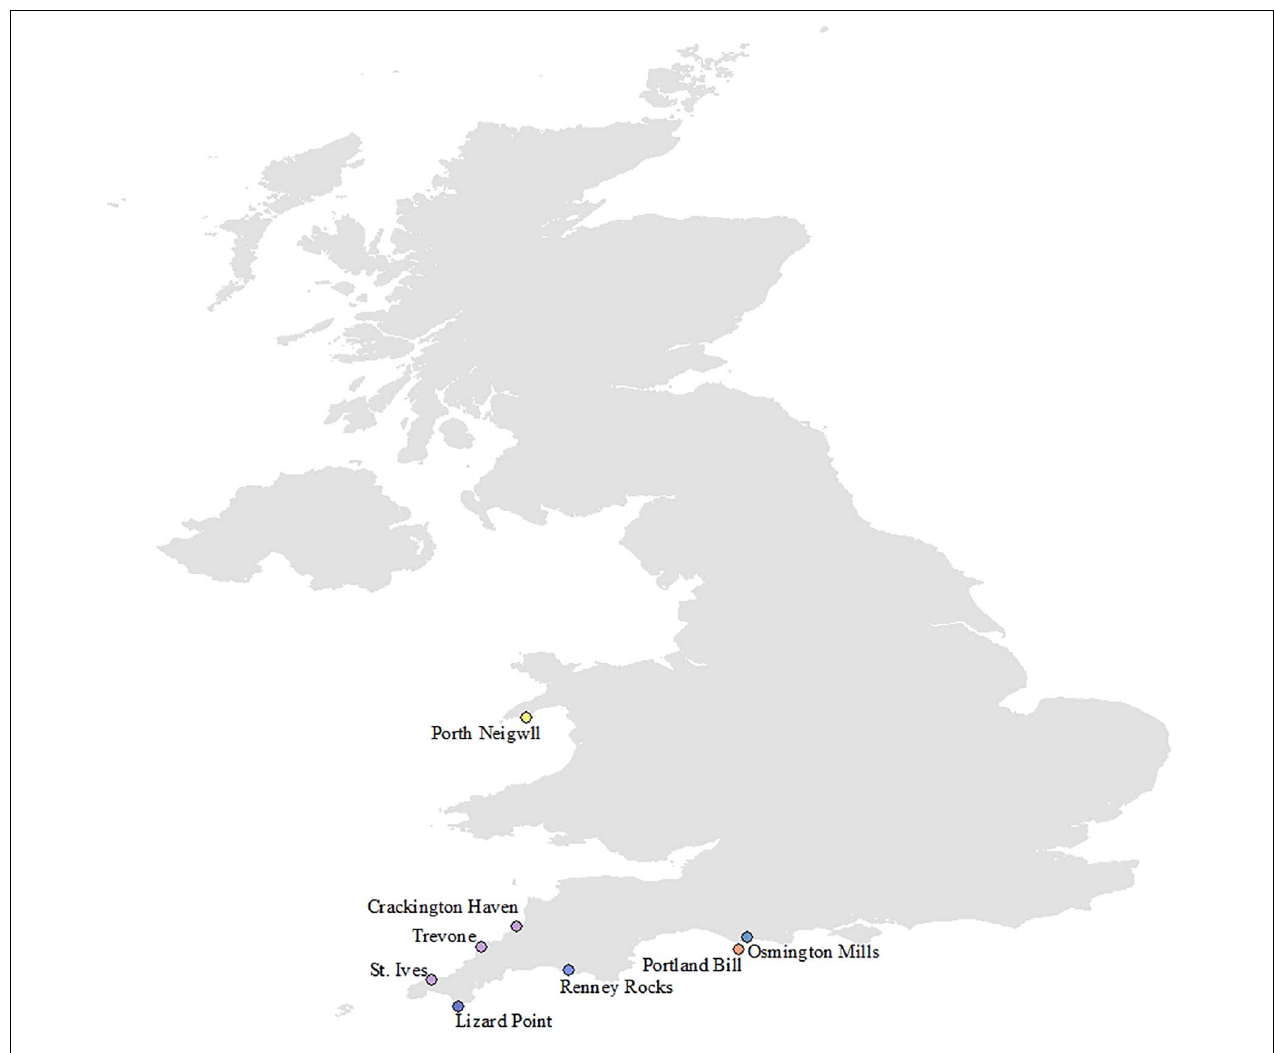
FIGURE 6 | MarClim sites where storm damage was recorded in England and Wales, and biannual storm damage survey locations at Crackington Haven, Trevone, and St.